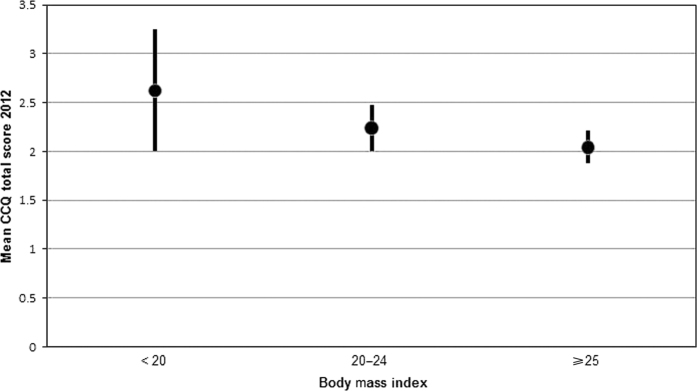
Body mass index and health status. Mean CCQ total scores in 2012 distributed over BMI groups. BMI, body mass index; CCQ, Clinical COPD Questionnaire.